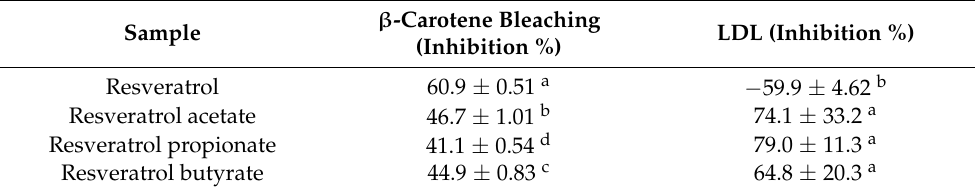
Table 3. Inhibitory effects of resveratrol and its esters against β -carotene bleaching and Cu 2+ -induced low-density lipoprotein (LDL)